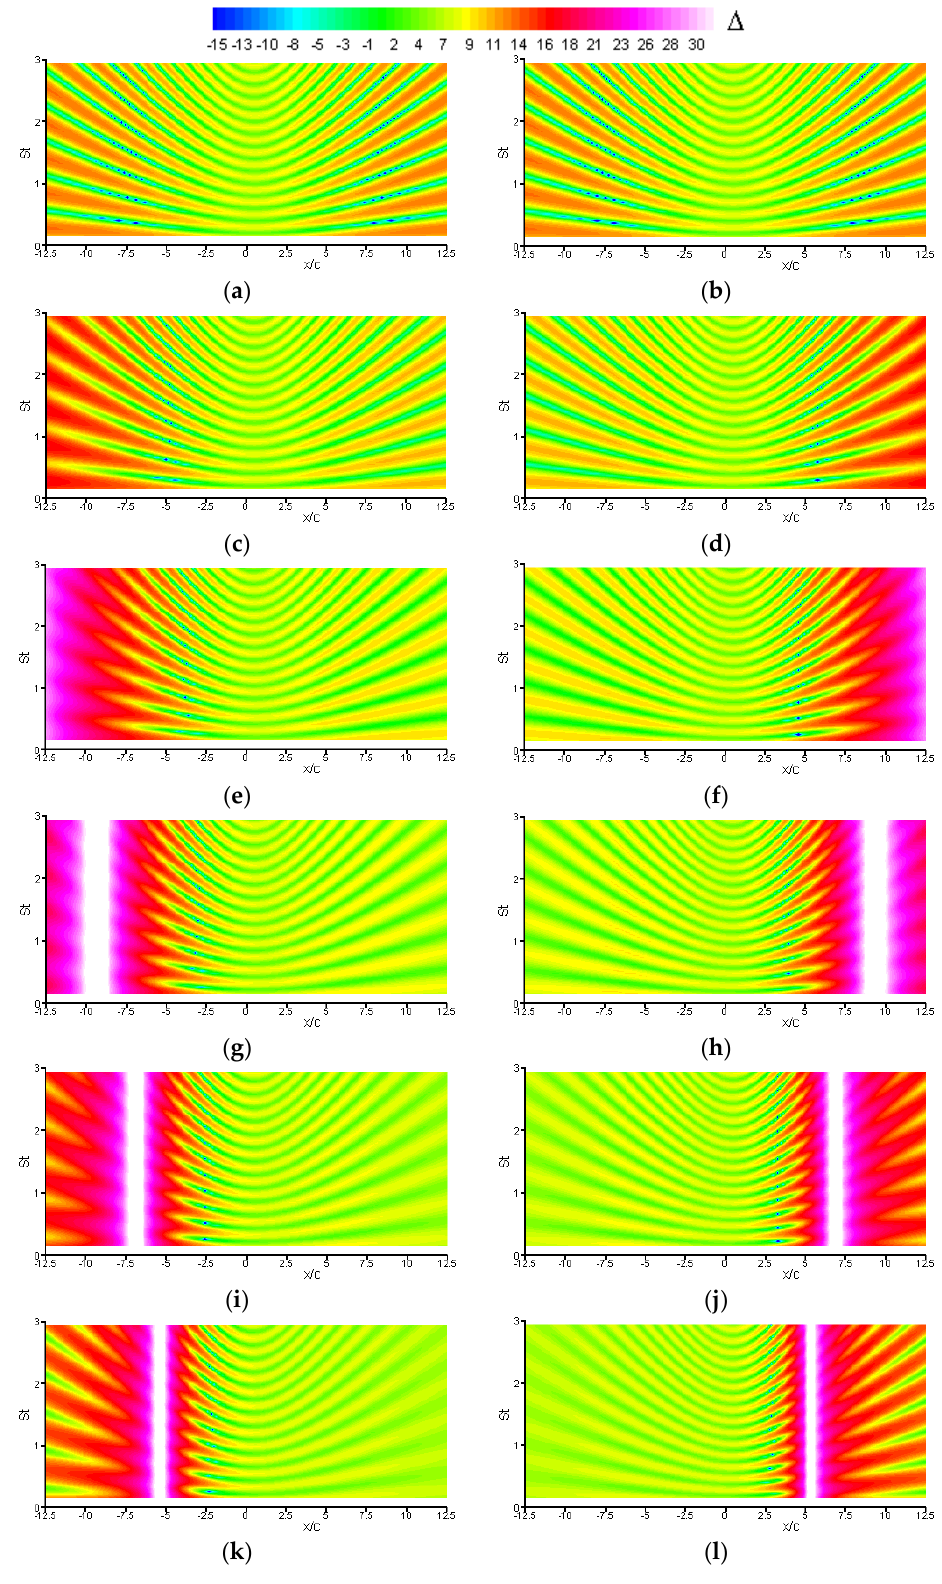
Figure 11. Low to high frequency (St = [0.0147; 2.94]) noise radiation from the trailing edge of an airfoil set at low to high incidences (from top to bottom): α = 0° ( a , b ), α = 5° ( c , d ), α = 10° ( e , f ), α = 15° ( g , h ), α = 20° ( i , j ), α = 25° ( k , l ). Deltas (in dB) between the incident and total RMS pressure fields, as recorded along the top (left: a , c , e , g , i , k ) and bottom (right: b , d , f , h , j , l ) walls.